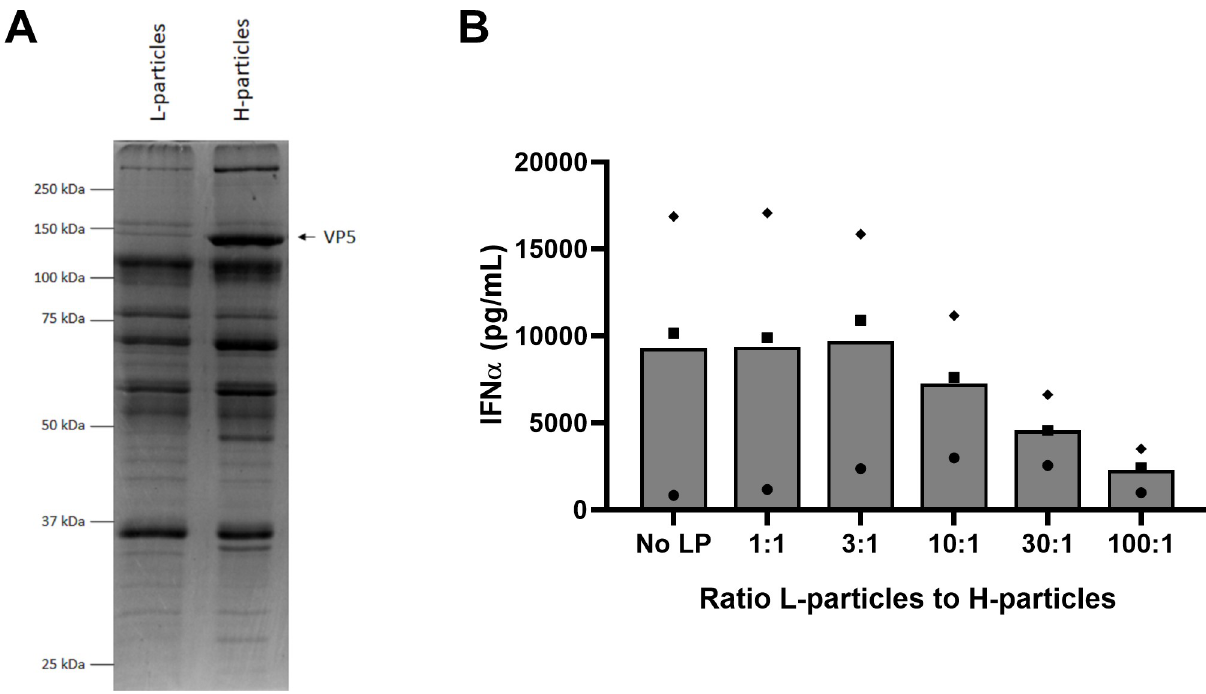
Fig 8. HSV-1 L-particles interfere with the H-particle-induced IFN α response by human PBMC in a dose dependent manner. (A) Coomassie blue staining of density gradient purified HSV-1 L- and H-particles. Arrow indicates position of the VP5 major capsid protein that is present in H-particles but absent from L-particles. (B) Human PBMC were incubated for 22h with density gradient purified HSV-1 H-particles and different amounts of HSV- 1 L-particles. IFN α responses of PBMC of three different donors are